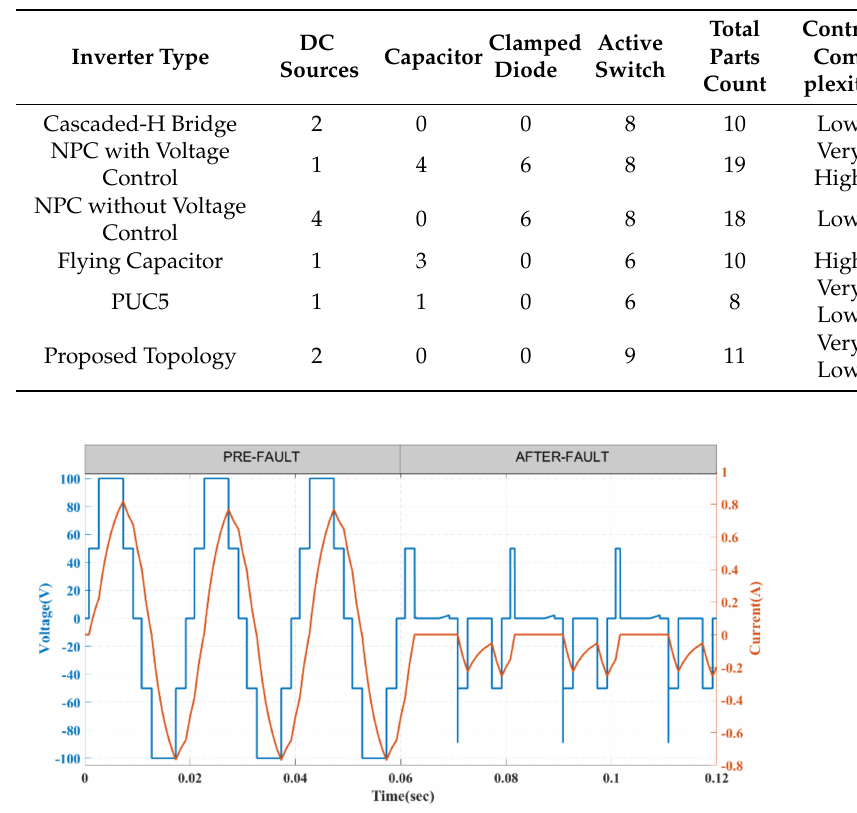
Table 6. Comparison table for single-phase five-level.